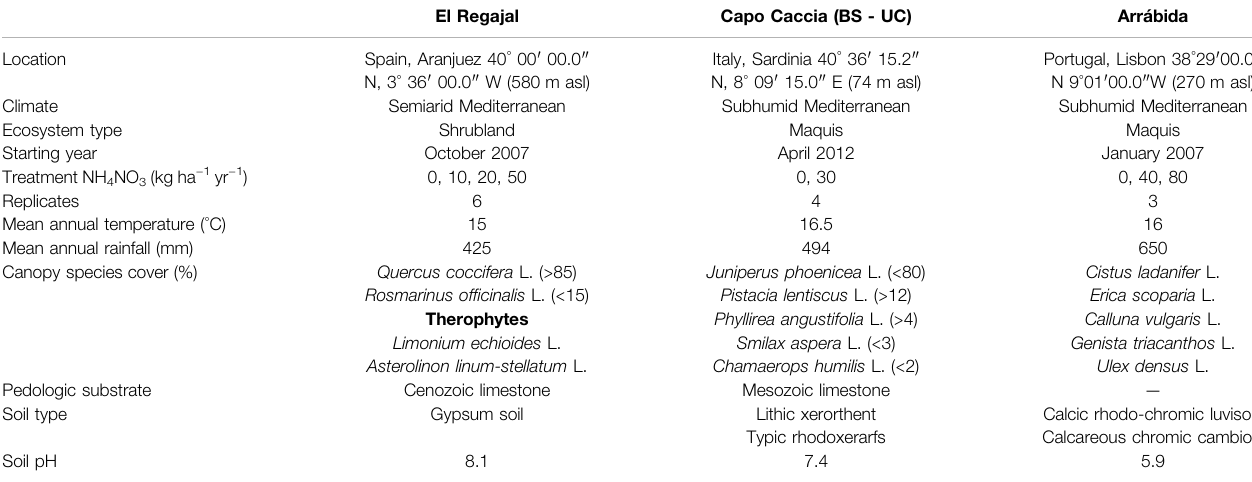
TABLE 1 | Main characteristics of the experimental